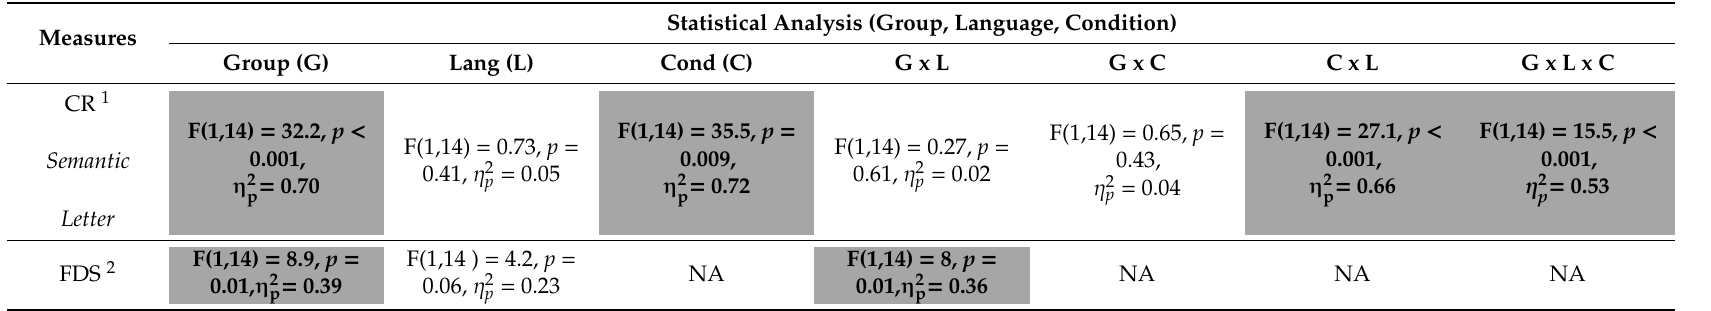
Table A3. Statistical results of the verbal fluency variables by Group, Conditions, and